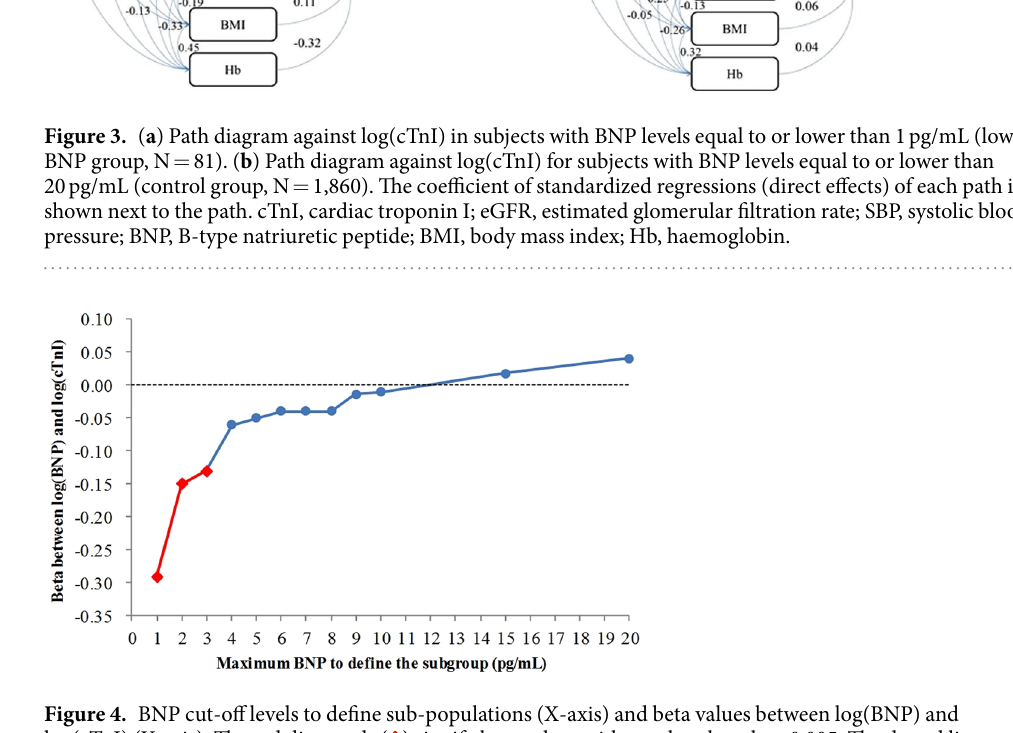
Figure 4. BNP cut-off levels to define sub-populations (X-axis) and beta values between log(BNP) and log(cTnI) (Y-axis). The red diamonds ( ) signify beta values with p-values less than 0.005. The dotted line signifies beta = 0. BNP, B-type natriuretic peptide; cTnI, cardiac troponin